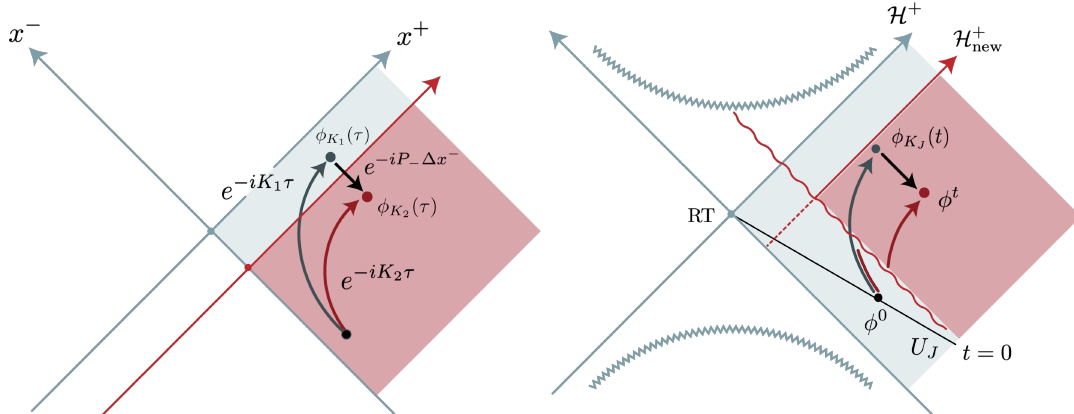
Figure 6. LEFT: two null separated Rindler wedges in Minkowski space and the corresponding vacuum state modular flows, generating boosts about the boundary of the corresponding wedge. Saturation of modular chaos is manifested in the exponential deviation of the two trajectories. RIGHT: backreaction of a black hole spacetime due to an infalling particle and the comparison between the action of the modular flowed operator φ and the proper time evolved operator φ t on K J H the state | Ψ . The former preserves the distance of the excitation from the RT surface whereas the J i later preservers the distance from the local horizon, up to exponentially decaying corrections. The exponential deviation of the two trajectories at late times reflects the Shapiro shift of the location of the horizon which is manifested quantum mechanically in the saturation of the modular chaos bound — in direct analogy to the physical interpretation of maximal modular chaos in the LEFT